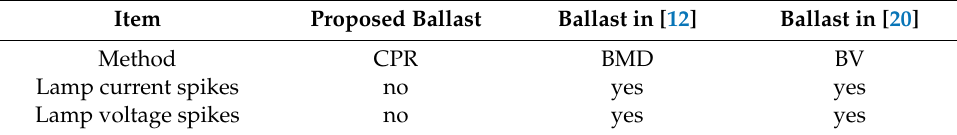
Table 6. Comparison of the EFL lamps dimming: proposed ballast and ballasts in [12] and [20].